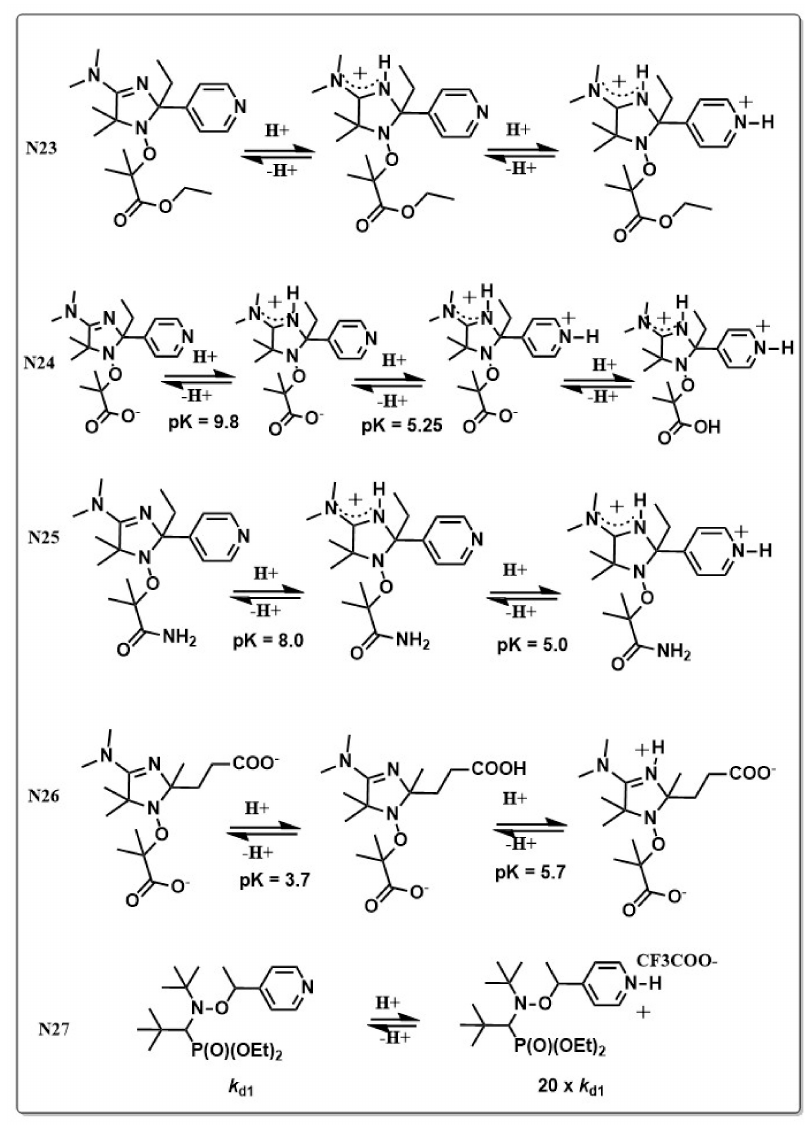
Chart 5. Alkoxyamines for pH triggered C–ON bond homolysis used in